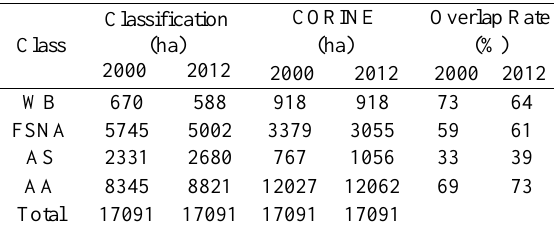
Table 3. The comparison results for classification